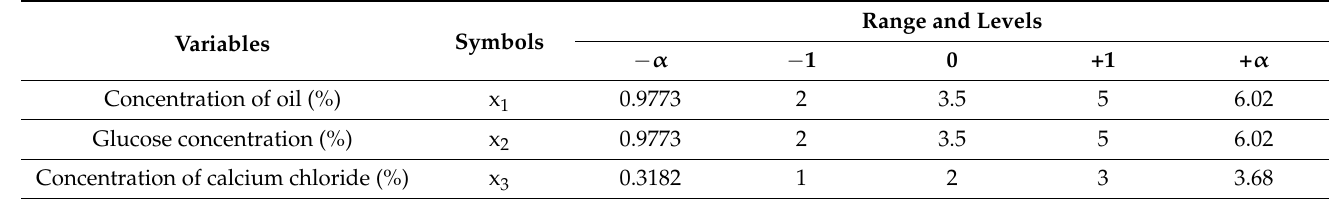
Table 1. Degrees of independent (predictor) variables and the range of